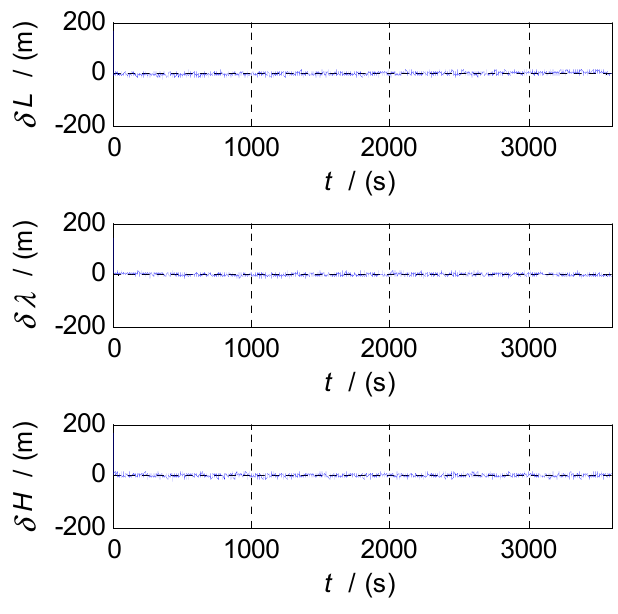
Figure 15. Position errors of SINS / CNS / GPS integration using CF.